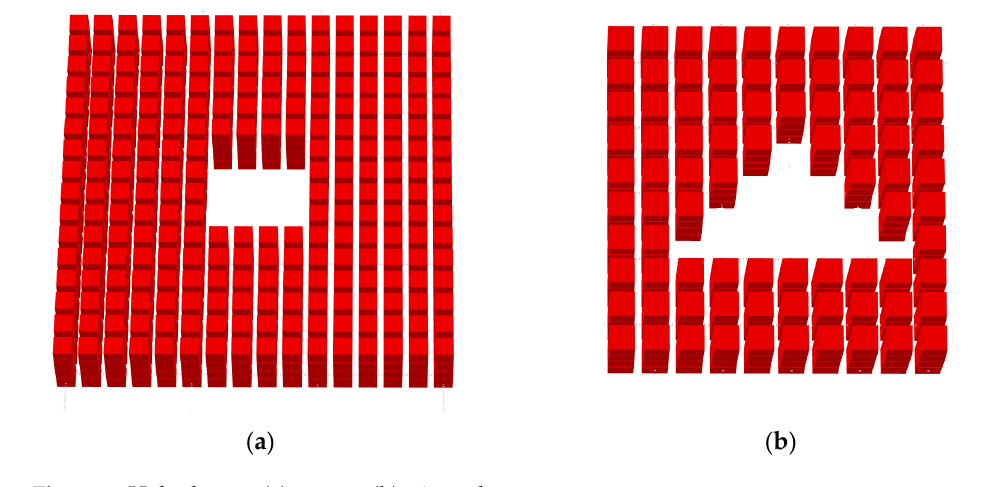
Figure 4. Hole shapes: ( a ) square, ( b ) triangular.